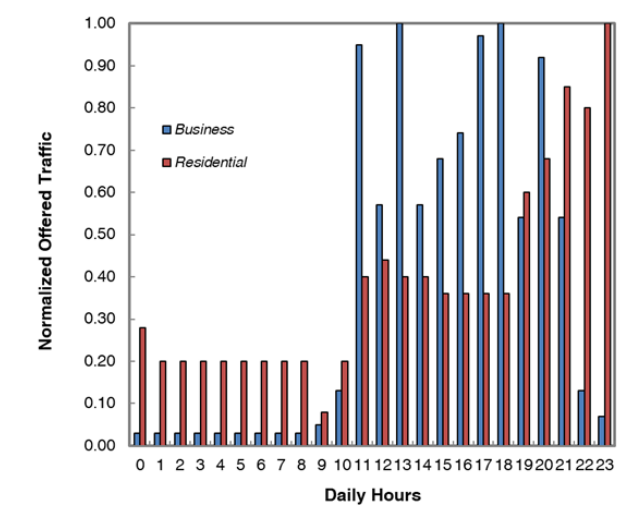
Figure 4. Normalized traffic profile for business and residential